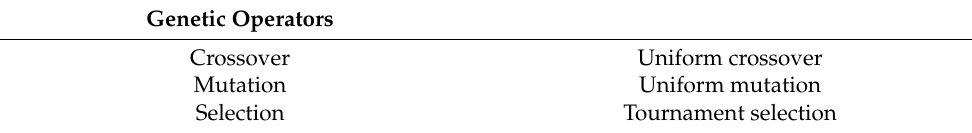
Table 6. Genetic